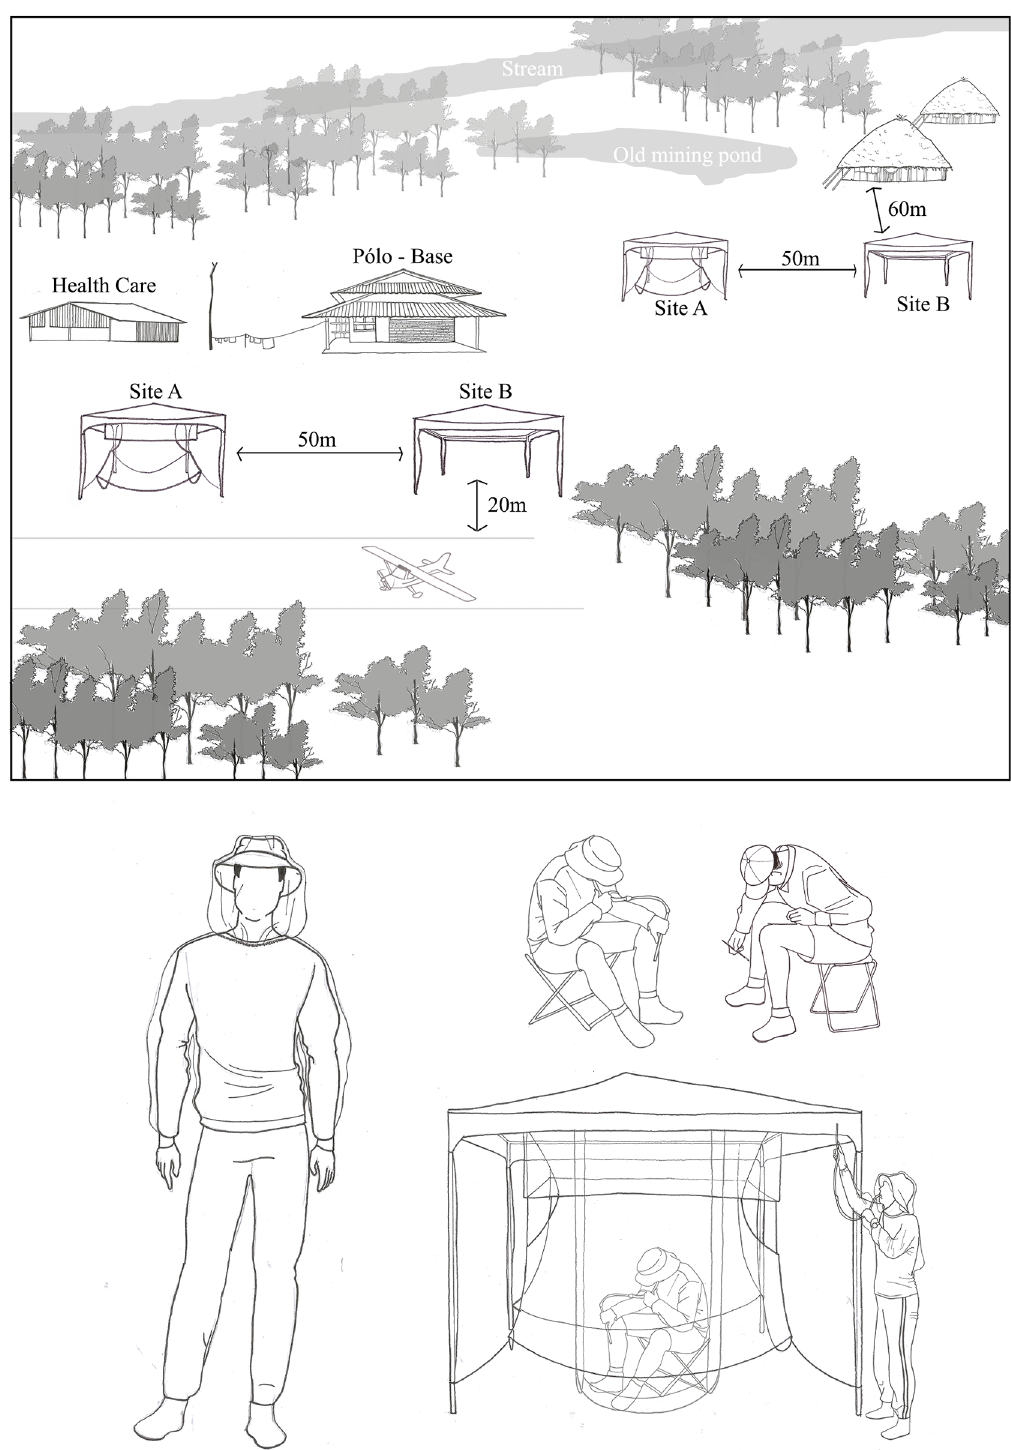
Fig 2. Experimental design—Scheme of the collection sites and surroundings.